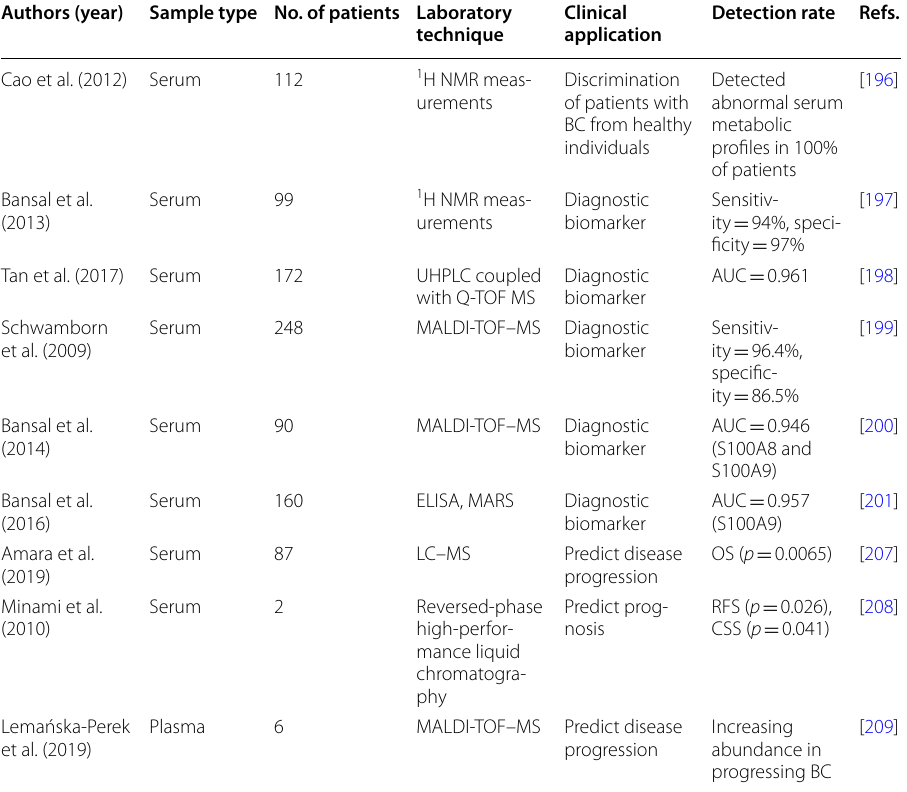
Table 5 Studies regarding circulating metabolomics and proteomics in blood as potential biomarkers for bladder